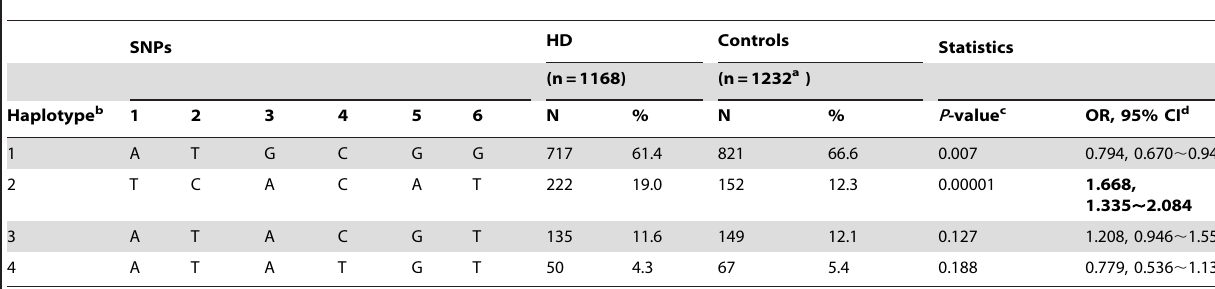
Table 2. The frequencies of haplotypes in block 1 and their association with